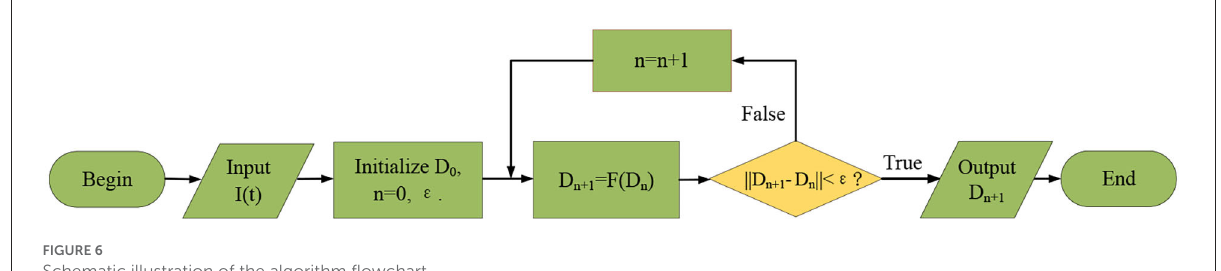
Algorithm 1. F STMD Iterative algorithm.